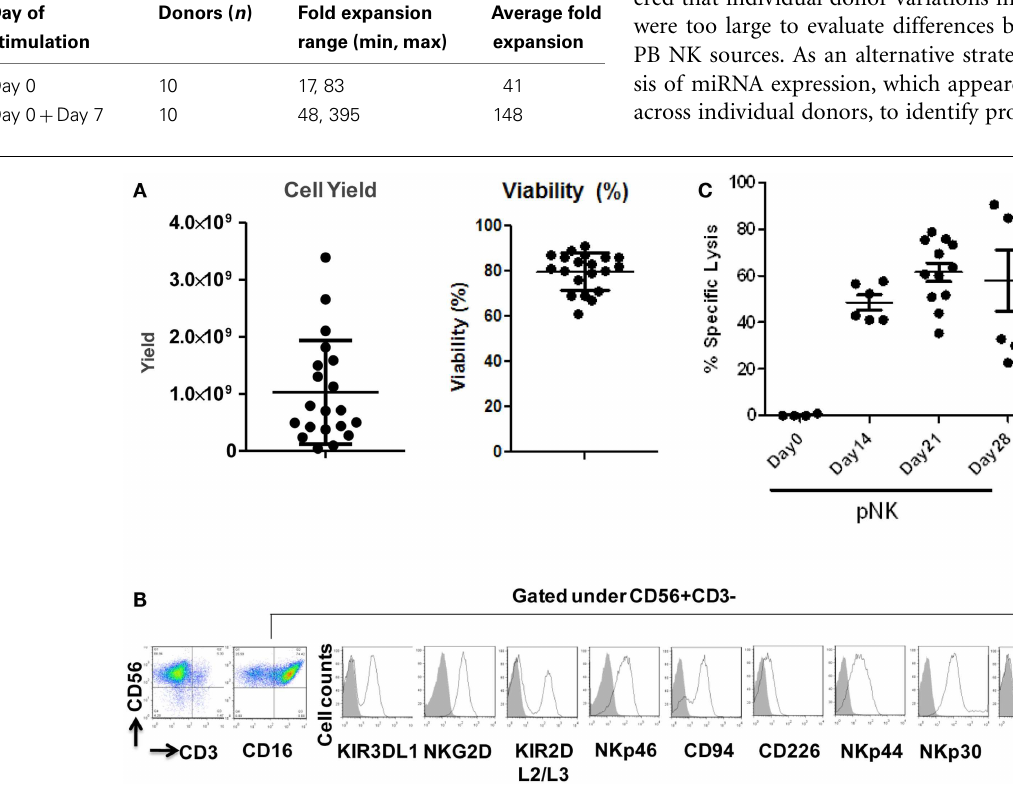
Table 7 | Effect of feeder replenishing at different time points.